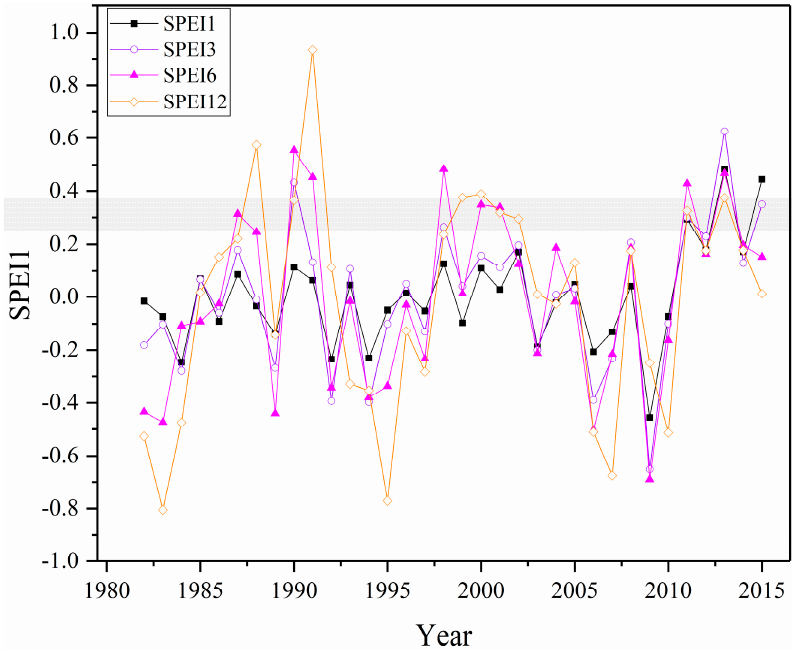
Figure 4. Changes of SPEI at di ff erent time scales.